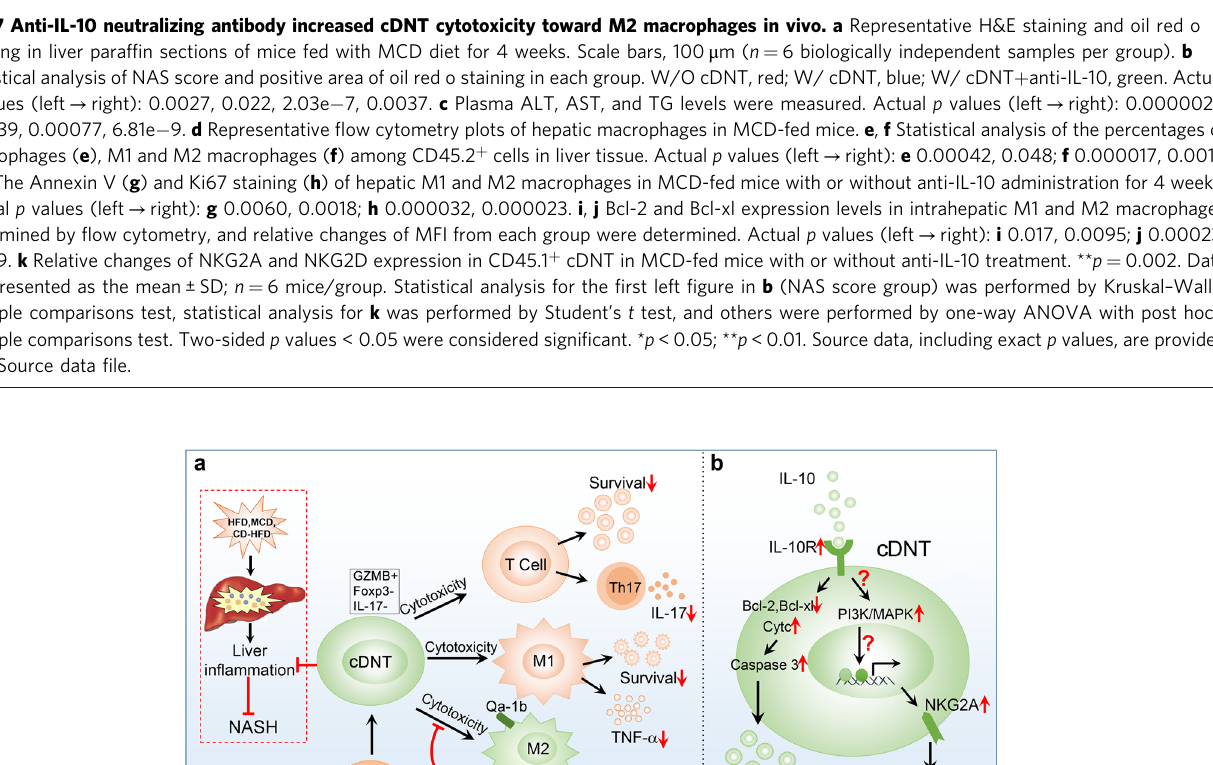
Fig. 7 Anti-IL-10 neutralizing antibody increased cDNT cytotoxicity toward M2 macrophages in vivo. a Representative H&E staining and oil red o staining in liver paraf fi n sections of mice fed with MCD diet for 4 weeks. Scale bars, 100 μ m ( n = 6 biologically independent samples per group). b Statistical analysis of NAS score and positive area of oil red o staining in each group. W/O cDNT, red; W/ cDNT, blue; W/ cDNT + anti-IL-10, green. Actual p values (left → right): 0.0027, 0.022, 2.03e − 7, 0.0037. c Plasma ALT, AST, and TG levels were measured. Actual p values (left → right): 0.000002, 0.0039, 0.00077, 6.81e − 9. d Representative fl ow cytometry plots of hepatic macrophages in MCD-fed mice. e , f Statistical analysis of the percentages of macrophages ( e ), M1 and M2 macrophages ( f ) among CD45.2 + cells in liver tissue. Actual p values (left → right): e 0.00042, 0.048; f 0.000017, 0.0011. g , h The Annexin V ( g ) and Ki67 staining ( h ) of hepatic M1 and M2 macrophages in MCD-fed mice with or without anti-IL-10 administration for 4 weeks. Actual p values (left → right): g 0.0060, 0.0018; h 0.000032, 0.000023. i , j Bcl-2 and Bcl-xl expression levels in intrahepatic M1 and M2 macrophages